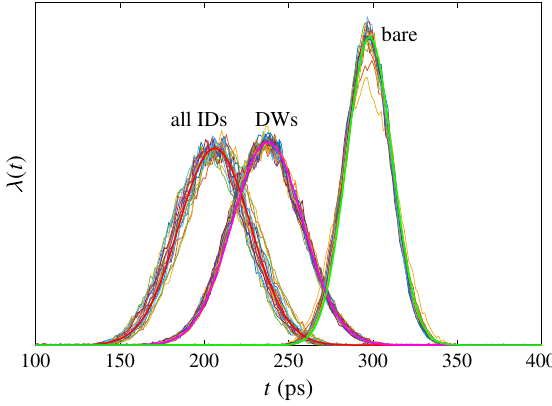
FIG. 5. Bunch profiles measured by streak camera.